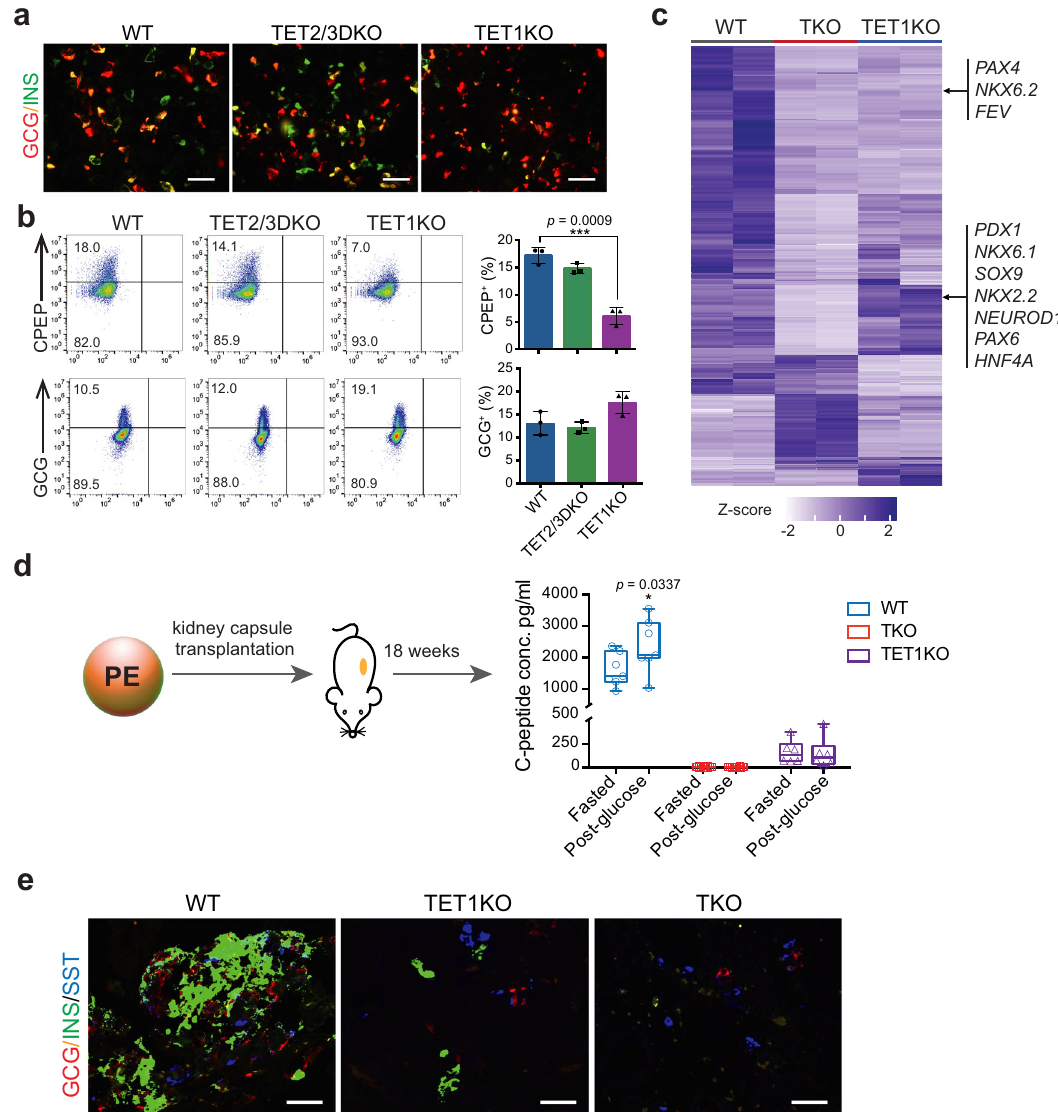
Fig. 5 TET1-knockout cells show impaired differentiation into functional β -cells. a Immunostaining of INS, and GCG in WT, TET2/3DKO, and TET1KO cells at the PE stage ( n = 3 independent differentiation; scale bar = 50 μ m). b Representative plots of fl ow cytometry of human C-peptide (CPEP) and glucagon (GCG) in WT, TET2/3DKO, and TET1KO cells at the PE stage. Quanti fi cations of the percentage of CPEP + or GCG + cells are shown in the right panel. ( n = 3 independent differentiations; student ’ s t -test, 2-sided; without multiple test correction). All bar graphs show mean ± SD. c Heatmap showing the hierarchical clustering of DEGs among WT, TKO, and TET1KO cells at the PP stage. Each row represents one DEG, and each column represents one biological replicate. The color scale from white to blue represents normalized gene expression levels from low to high (|fold change| ≥ 2; FDR < 0.05). d WT ( n = 7), TKO ( n = 12), and TET1KO ( n = 6) cells were differentiated to the PE stage and transplanted under the kidney capsule of nondiabetic female SCID-beige mice. Eighteen weeks post-implantation, human C-peptide levels were measured after an overnight fast and 30 min following an i.p. glucose injection. C-peptide levels from individual mice are shown in box and whisker plots (Plots are centered on mean, with box encompassing 25th-75th percentile and whiskers representing minimum to maximum range; student ’ s t -test, 1-sided; without multiple test correction). e Immunostaining of insulin (INS), glucagon (GCG), and somatostatin (SST) in cell grafts from WT_PE, TET1KO_PE, and TKO_PE transplanted mice ( n = 2 independent experiments; scale bar = 50 µ